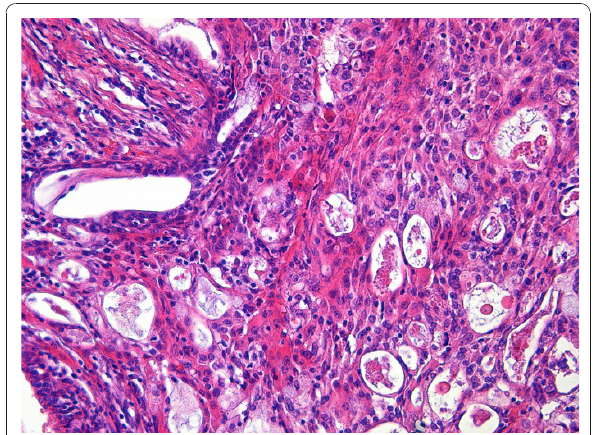
Figure 1 Microphotograph of the region of interest (ROI) of a mucoepidermoid carcinoma of the lung (HE, *200). To view the virtual slide for this image please see here http://eu-demo-dih.